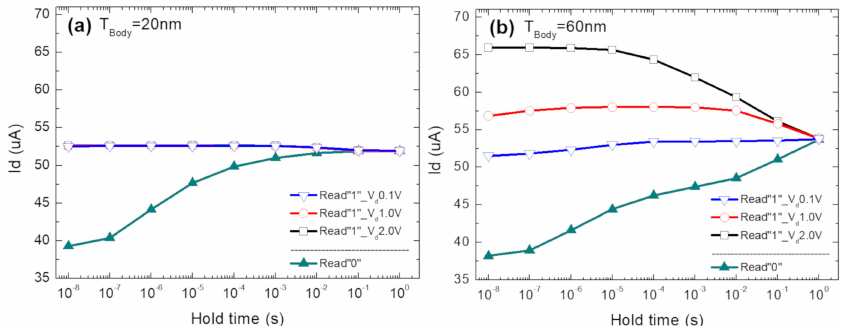
Figure 4. Transient characteristics of ( a ) T Body 20 nm and ( b ) T Body 60 nm cells according to drain voltage condition in Write“1”.